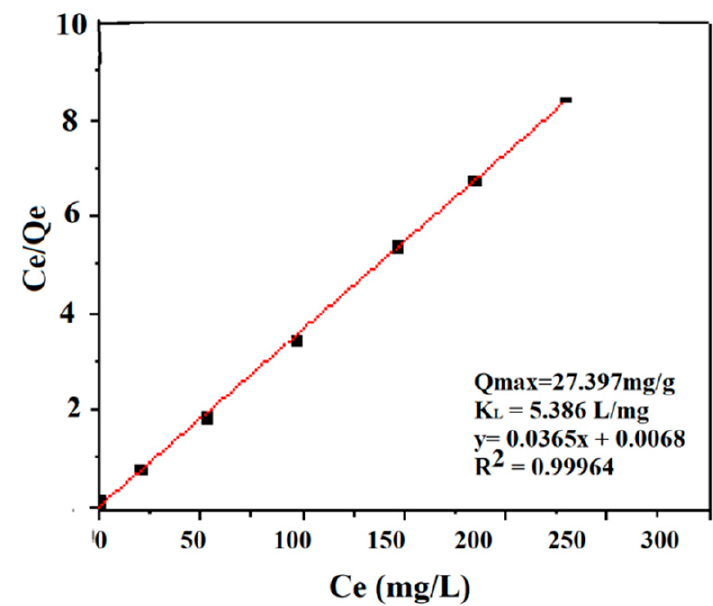
Figure 9. Linear plot of Langmuir isotherm model for Cr(VI) adsorption onto